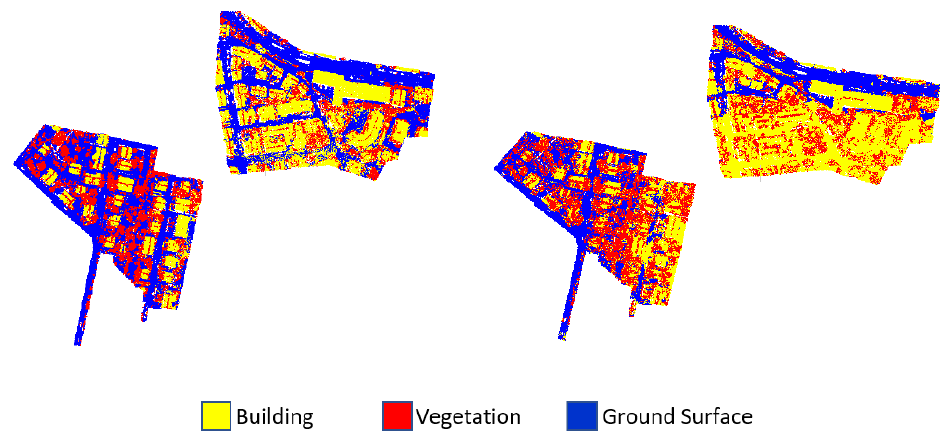
Table 5. The overall accuracy of the methods in Vaihingen. The highest-obtained accuracies are shown as bold.